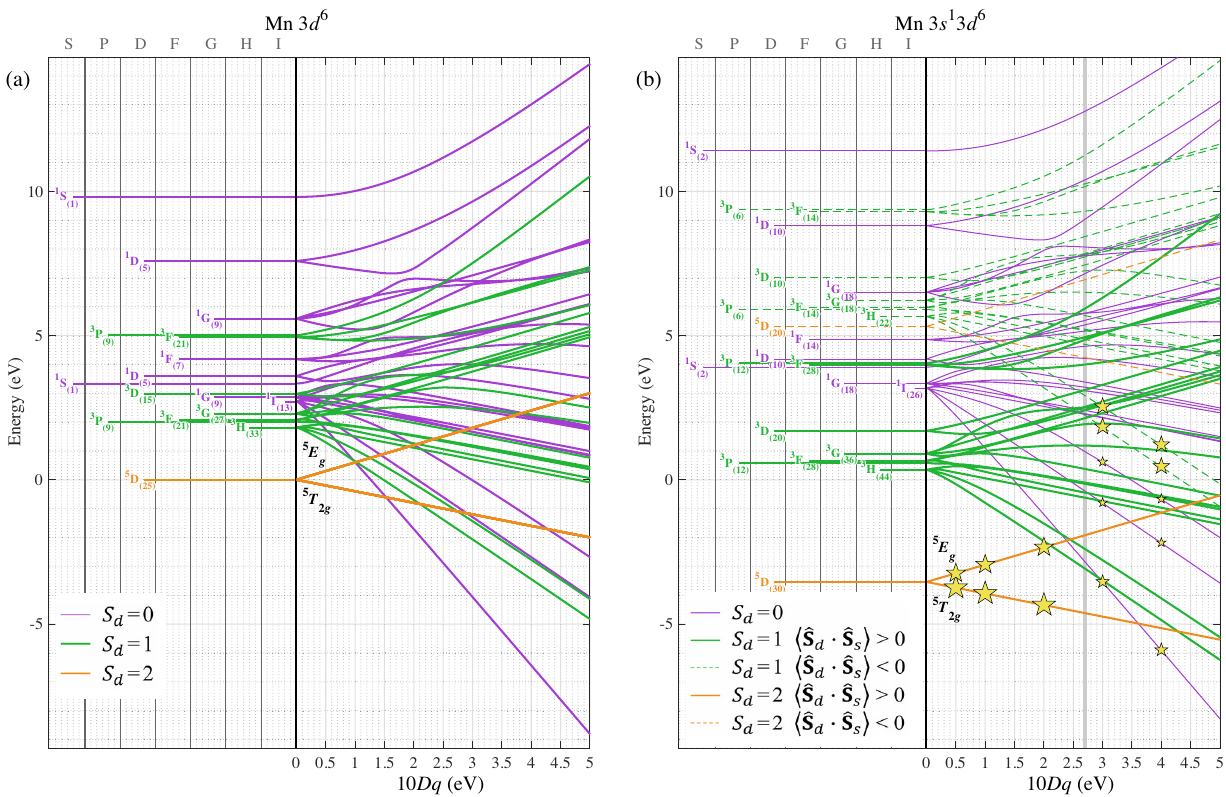
FIG. 5. Modified Sugano-Tanabe-Kamimura diagrams showing the dependence on 10 Dq of the energy levels of (a) Mn 3 d 6 (in absence of the core 3 s hole) and of (b) Mn 3 s 1 3 d 6 (the s -NIXS final state). The 0 eVenergy reference is the same for both panels, and it is fixed to the lowest state of Mn 3 d 6 at 10 Dq ¼ 0 eV. Each multiplet is labeled with the corresponding term symbol at 10 Dq ¼ 0 eV and in parentheses is indicated its degeneracy. The colors indicate each state ’ s spin multiplicity: purple for singlets, green for triplets, and orange for quintets. In panel (b), the thick full lines represent the states having parallel S antiparallel to S , and the thin full lines the states not affected by S s NIXS process, and the vertical gray line at 10 Dq ¼ 2 . 7 eV is the transition between the high- and low-spin configurations of the 3 d 5 ground state. The Slater parameters used for Mn 3 d 6 , after reduction to 80% of their atomic value, are F 2 3 ¼ 4 . 472 eV. The reduced Slater parameters for Mn 3 s 1 3 d 6 are F 2 F 4 3 d − 3 d ¼ 8 . 856 G 2 3 s − 3 d